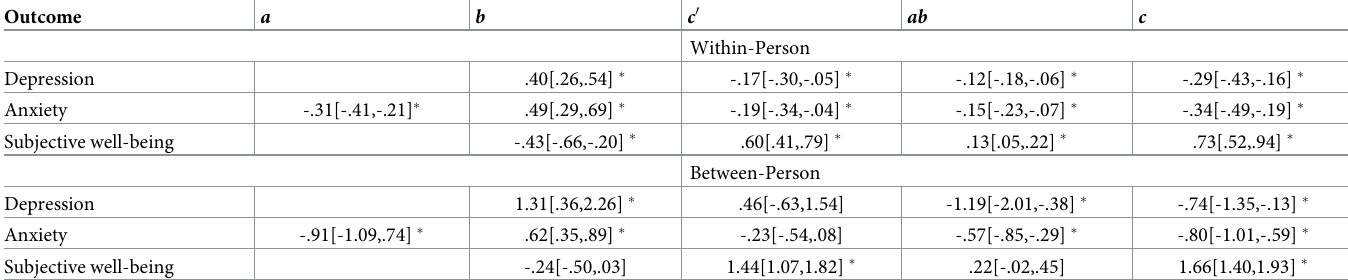
The numbers with asterisk ( � ) indicate significant results. Numbers within brackets are the lower and upper limits of confidence intervals. The coefficients a , b , c , and c 0 represent the paths from dispositional mindfulness to emotion dysregulation, from emotion dysregulation to mental health outcomes, and from dispositional mindfulness to mental health outcomes before and after controlling for the effect of emotion dysregulation. The coefficient ab represents the indirect effect of emotion dysregulation. Note that the within-person c 0 and c paths for depression was the average of c 0 and c paths across participants. The upper panel reports the results regarding the within-person level whereas the lower displays those for the between-person